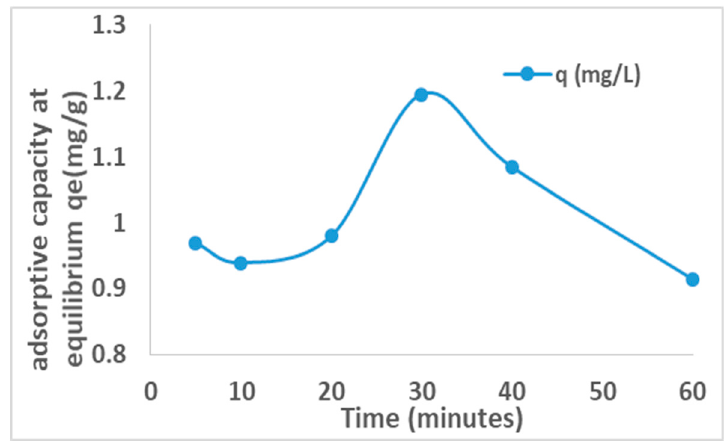
Figure 5. Plot of adsorptive capacity (mg/g) versus activation time (minutes).